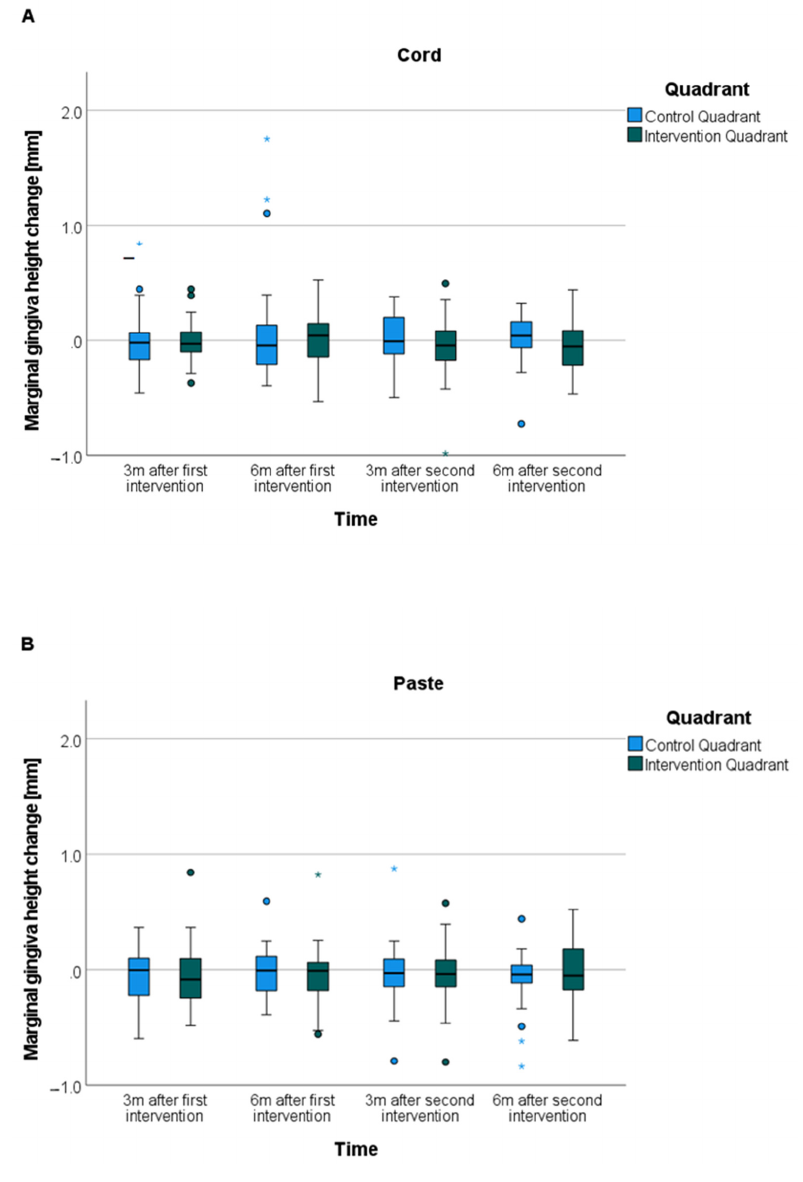
Figure 8. Marginal gingiva height change for control quadrant (no intervention) versus intervention quadrant (( A ) cord; ( B ) paste) for three months (3m) and six months (6m) after first intervention (healthy gingiva) and second intervention (artificial gingivitis); the circles represent outlier values (more than 1.5 times the box width away); the asterisks represent extreme values (more than 3 times the box width